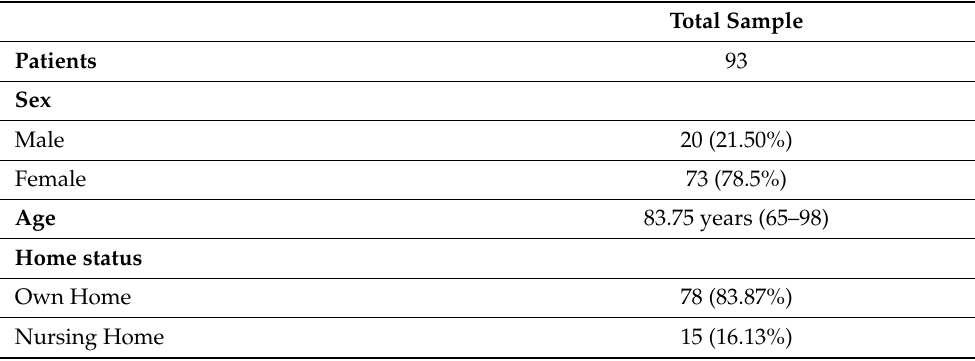
Table 1. Demographic data of the